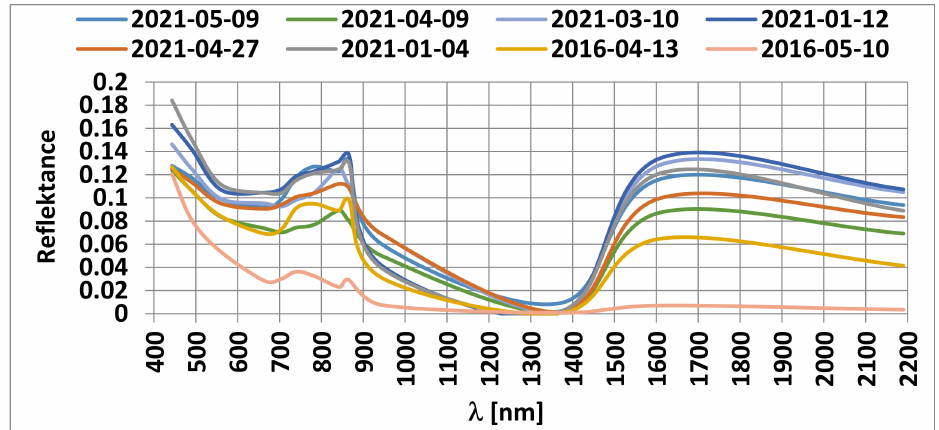
Figure 6. Some spectral curves for the fragment of the dam crest.